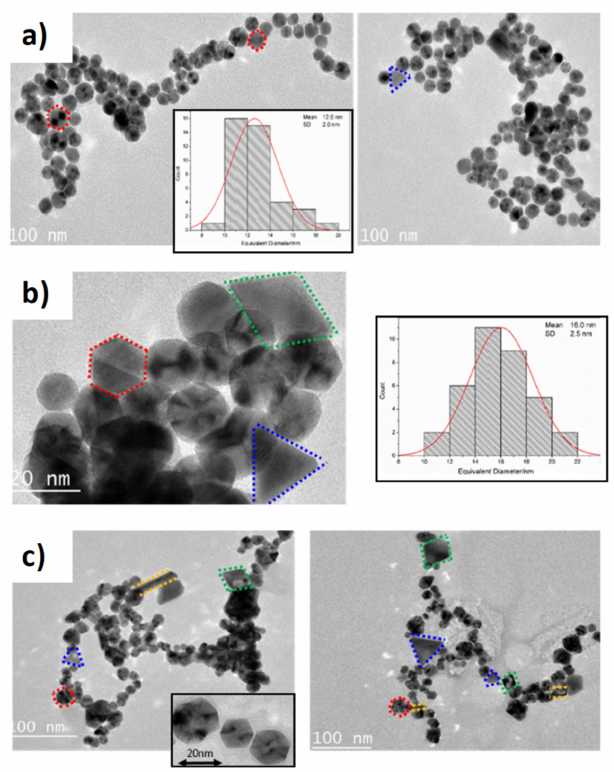
Figure 4. TEM pictures and size distribution of Pd NPs prepared by the supercritical fluidic approach from Pd(acac) 2 . Influence of some synthesis parameters. ( a ) 0.005 mol L − 1 of Pd, 0.05 mol L − 1 of formic acid (10/1), and 30 s. ( b ) 0.005 mol L − 1 of Pd, 0.10 mol L − 1 of formic acid (20/1), 0.02 mol L − 1 of oleylamine (4/1), and 30 s. ( c ) 0.01 mol L − 1 of Pd, 0.20 mol L − 1 of formic acid (20/1), and 83